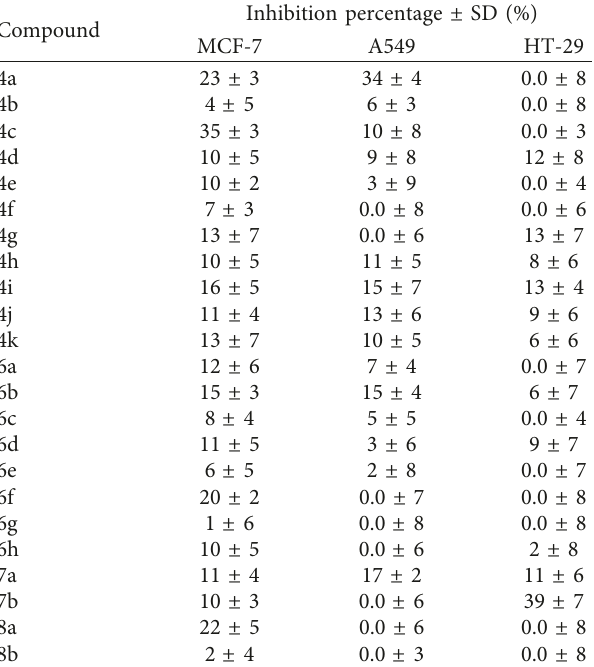
Table 1: Inhibition percentages of different synthesized com- pounds against MCF-7, A549, and HT-29 cell line.